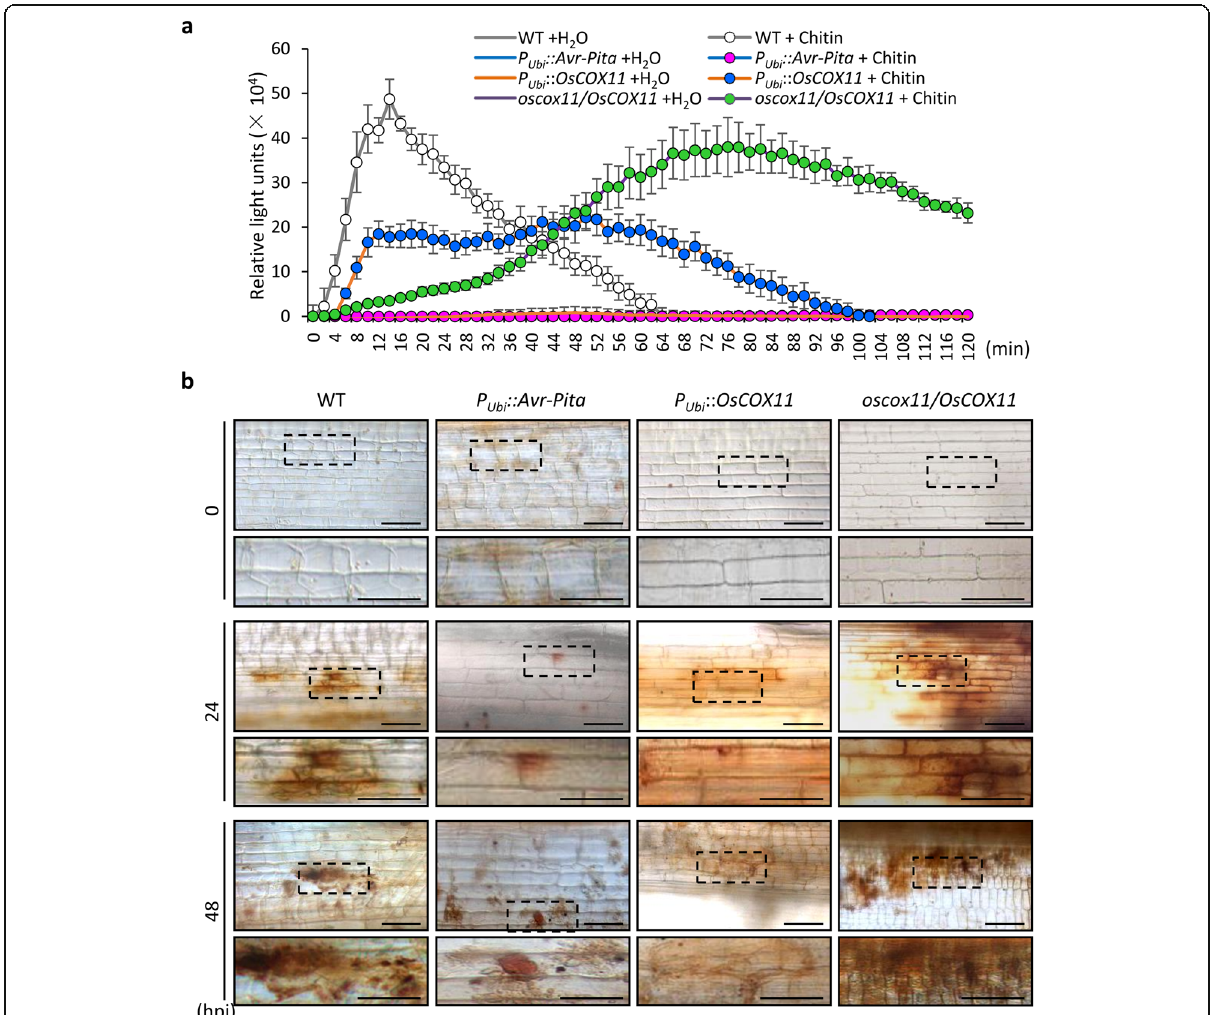
Fig. 5 Overexpressing Avr-Pita or OsCOX11 suppresses chitin-triggered ROS accumulation in rice. a Chitin-induced ROS accumulation in WT, P Ubi :: Avr-Pita , P Ubi ::OsCOX11 , and oscox11/OsCOX11 cells, as measured using a luminol-chemiluminescence assay. Data are shown as mean ± SD (** P < 0.01, n = 4). b ROS accumulation detected with DAB staining in WT, P Ubi ::Avr-Pita , P Ubi ::OsCOX11 , and oscox11/OsCOX11 plants after inoculation with M. oryzae . The images were taken at 0, 24, and 48 h post inoculation (hpi). Scale bars = 50 μ